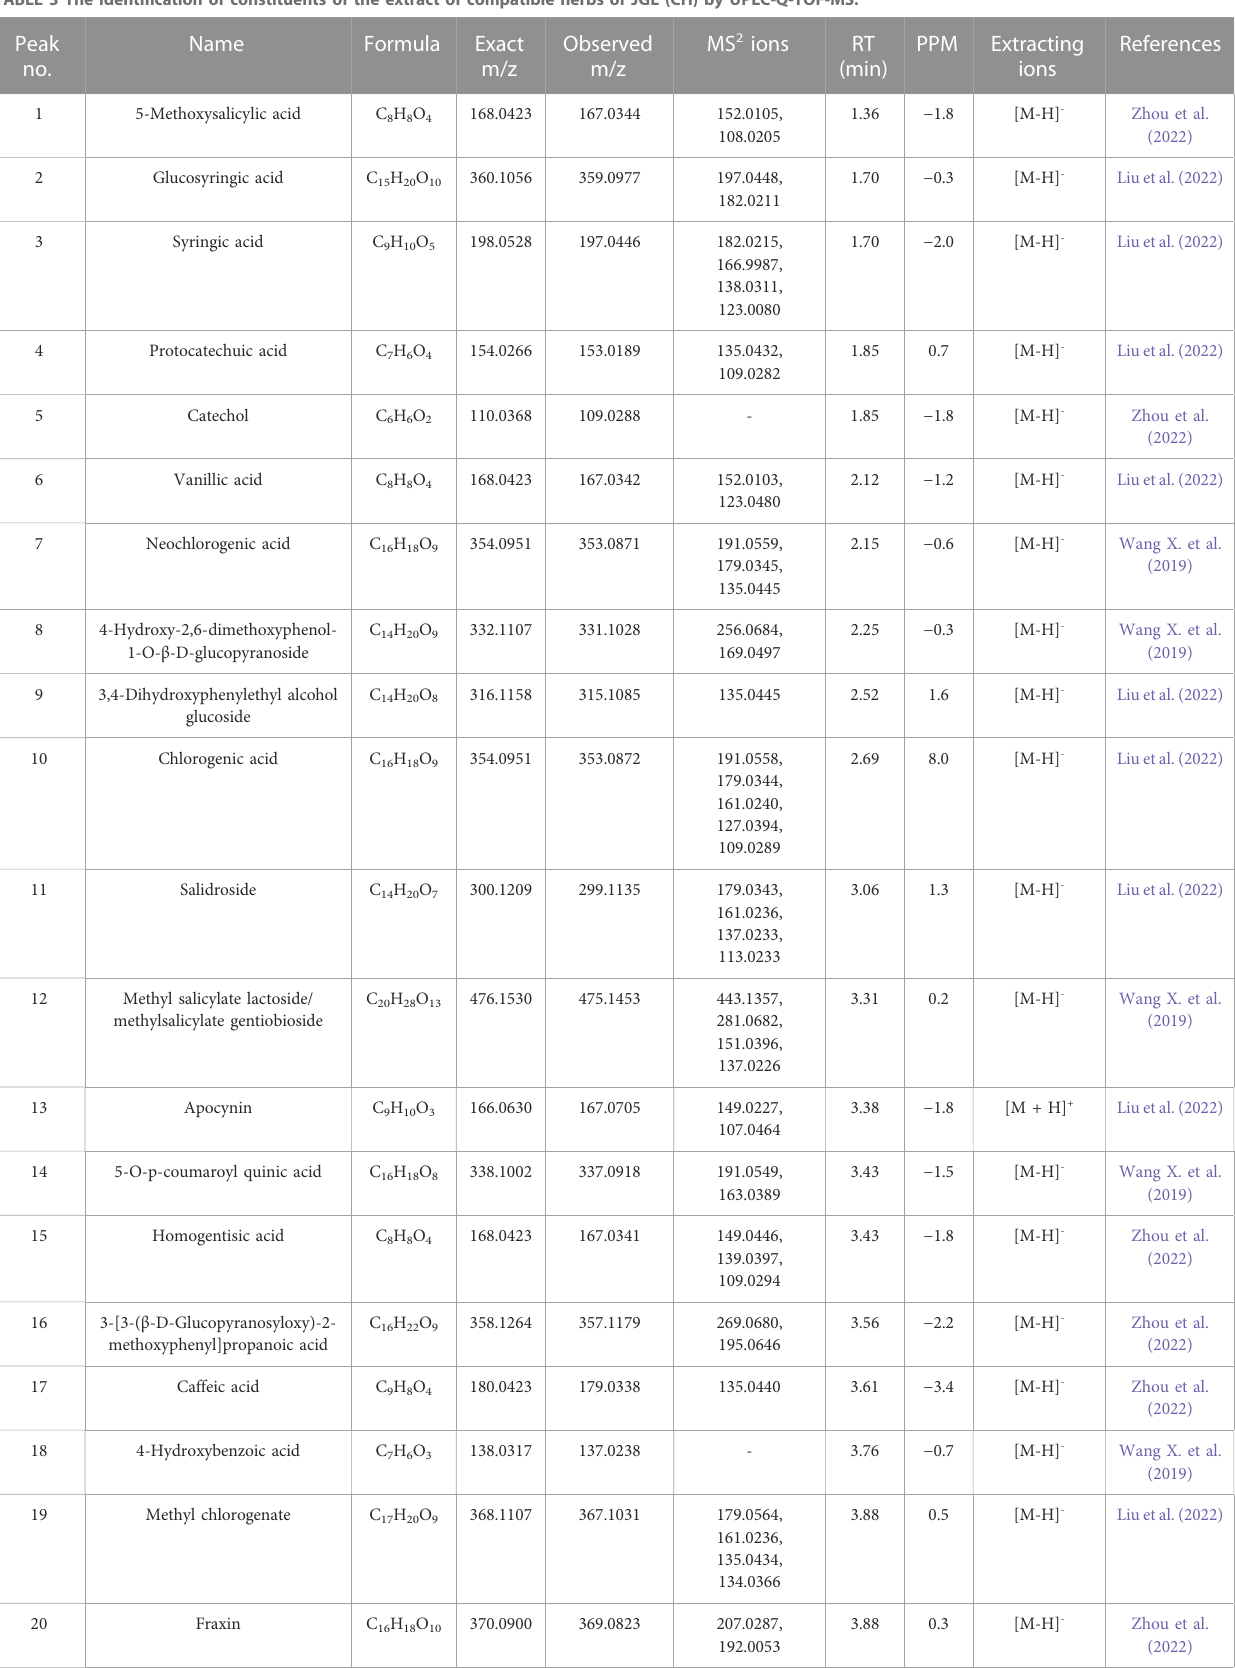
TABLE 3 The identi fi cation of constituents of the extract of compatible herbs of JGL (CH) by UPLC-Q-TOF-MS. Peak